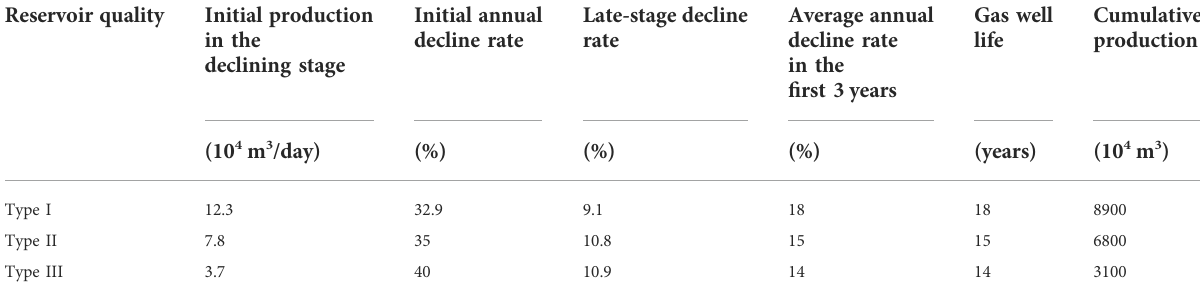
TABLE 3 Quantitative evaluation of the decline of the characteristic parameters of horizontal wells with different reservoir qualities. Reservoir